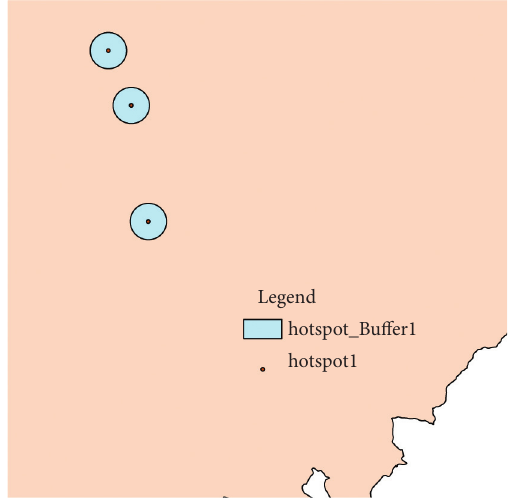
Figure 8: Examples of bike-sharing analysis areas